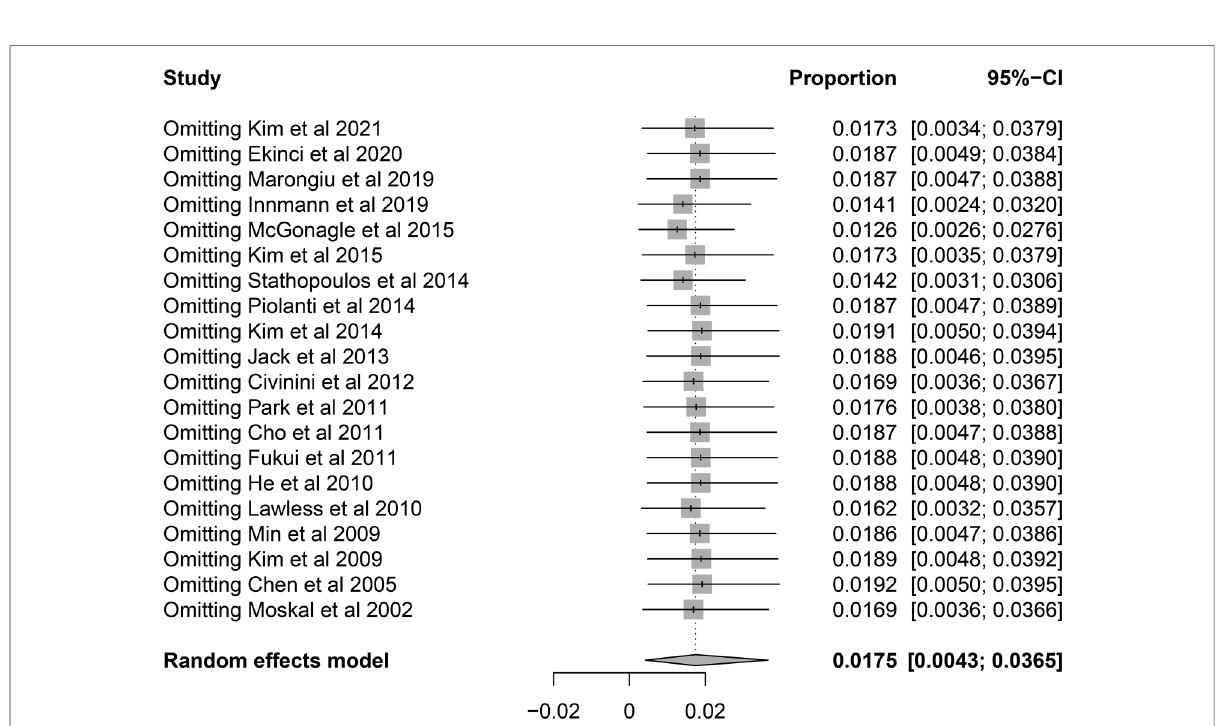
FIGURE 5 Sensitivity analysis for the re-revision rate of retained stems using leave-one-out